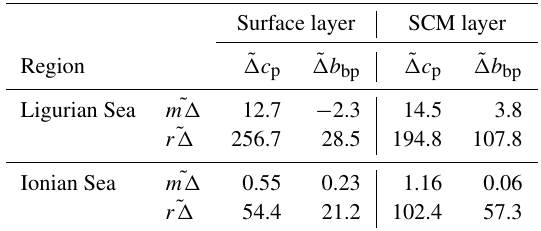
Table 3. Mean and range (%) in relative daily variations ( ˜ m(cid:49) and ˜ r(cid:49) , respectively) in the diel cycle of c p and b bp computed for each float over the entire time series, for the two considered regions and in the surface (0 − Z pd ) and SCM layers of the water